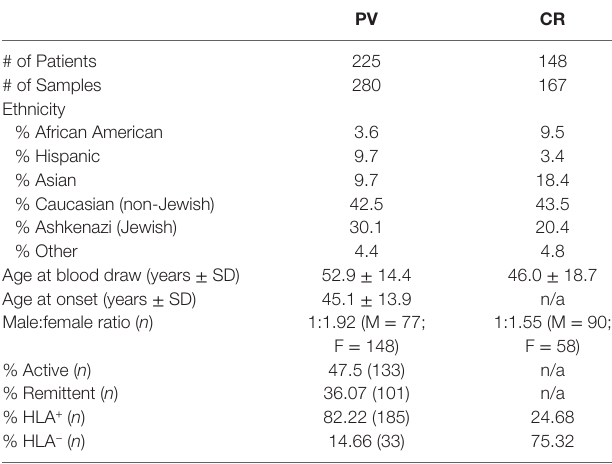
Table 1 | Study population demographic data and human leukocyte antigen (HLA)